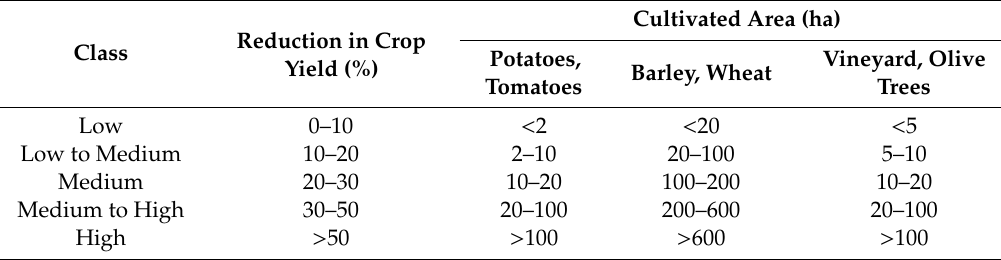
Table 2. Classification of values on crop yield change and cultivated area at municipal level,